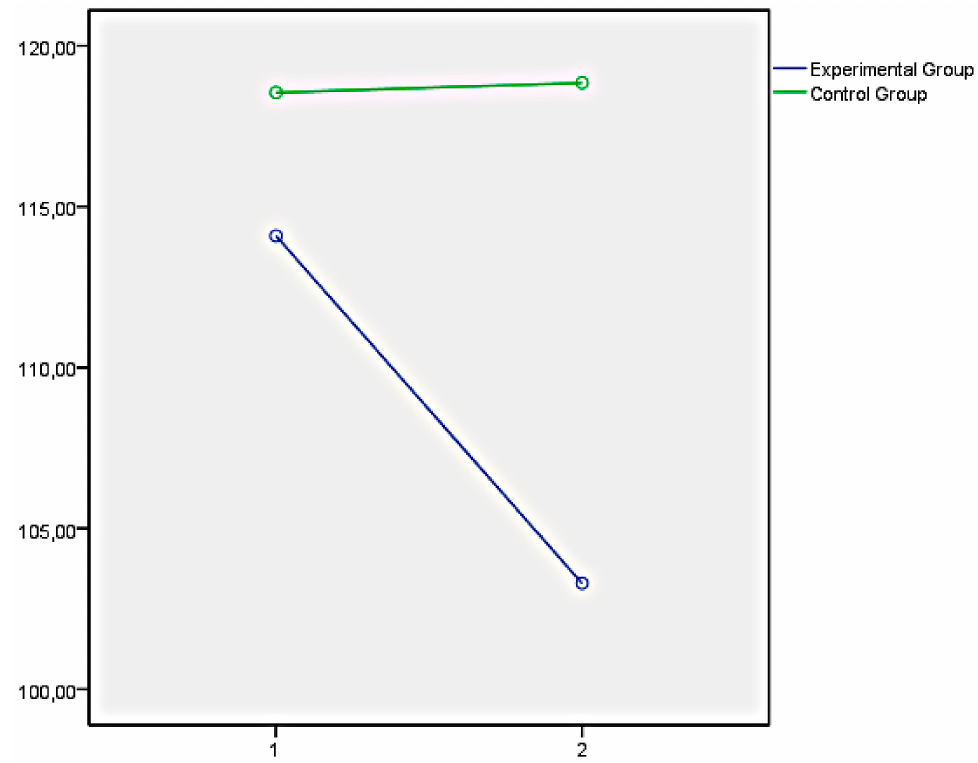
Figure 5. MESSY total score as a representation of the significant differences obtained in the set of factors of social skills measured with Matson Evaluation of Social Skills with Youngsters.